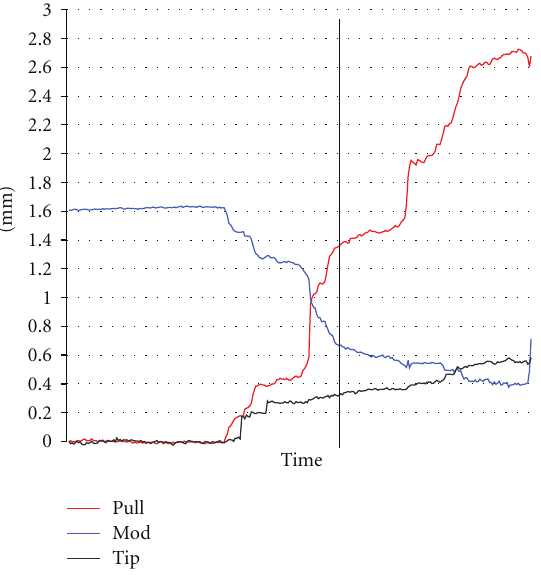
Figure 3: Exemplary graph of the distances estimated in a pullback procedure. Temporal changes of tip distance, approximation dis- tance and pullback distance. The point of optimal pullback amount is marked by a vertical line.